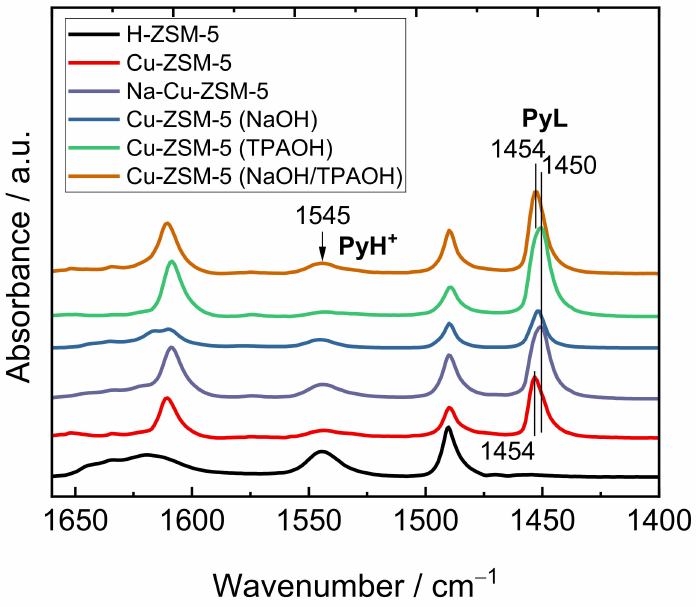
Figure 4. FT-IR spectra of adsorbed pyridine on H-ZSM-5, micro-/mesoporous Cu-exchanged ZSM-5 and Cu-exchanged ZSM-5 with